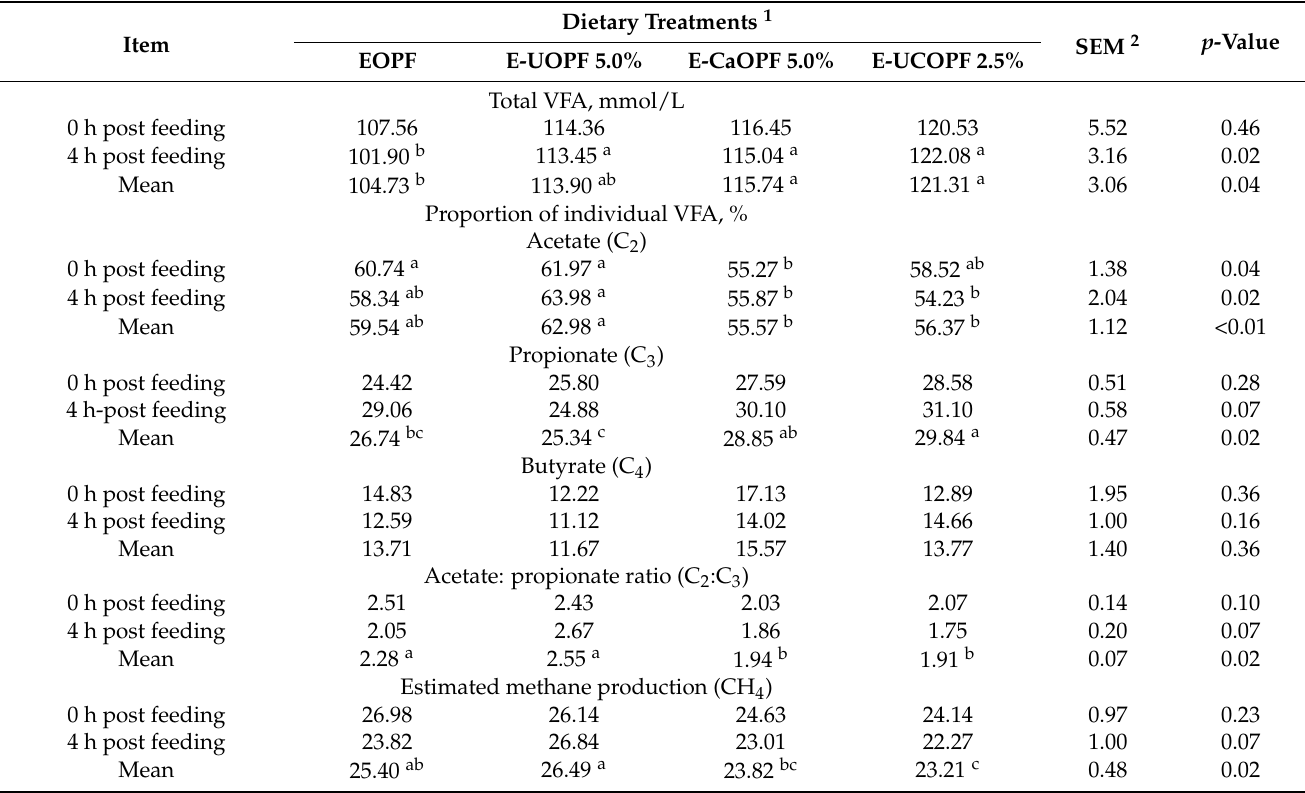
Table 6. Effect of ensiled oil palm fronds supplemented with urea-calcium hydroxide on volatile fatty acid profiles in goats. Item